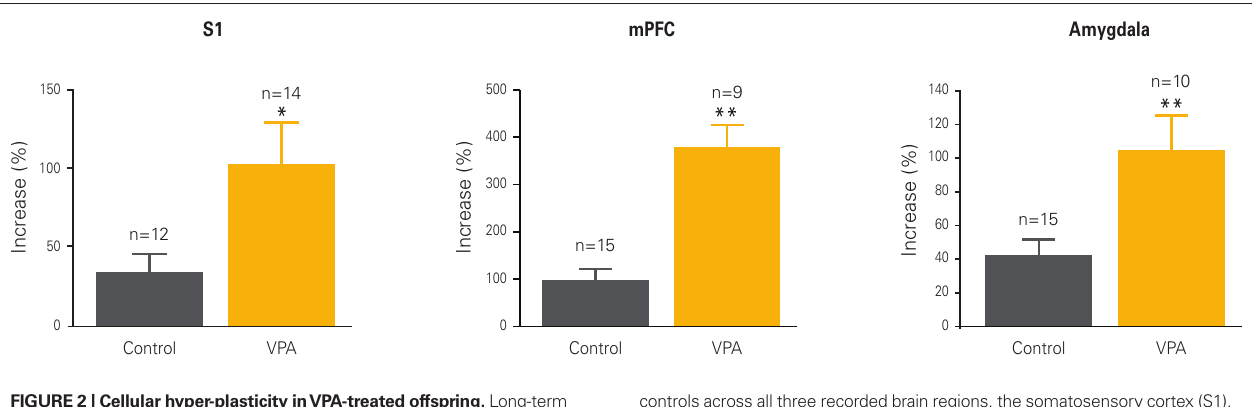
Figure 2 | Cellular hyper-plasticity in VPA-treated offspring. Long-term potentiation (LTP) is increased in neurons from VPA-treated offspring as compared to controls. The graphs depict the percentual increase in response amplitude recorded from neurons before and after a strong electrical stimulation. Increases are at least two to four times higher in VPA-treated offspring than